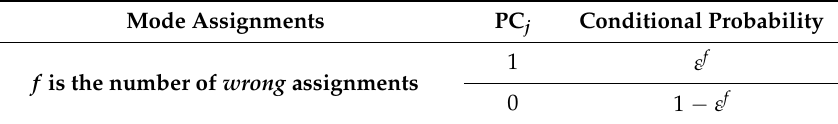
Figure 9. Structure of Mode Variables and Possible Conflicts. Table 1. Simplified Distribution of Mode Variable Assignments and Possible Conflicts.